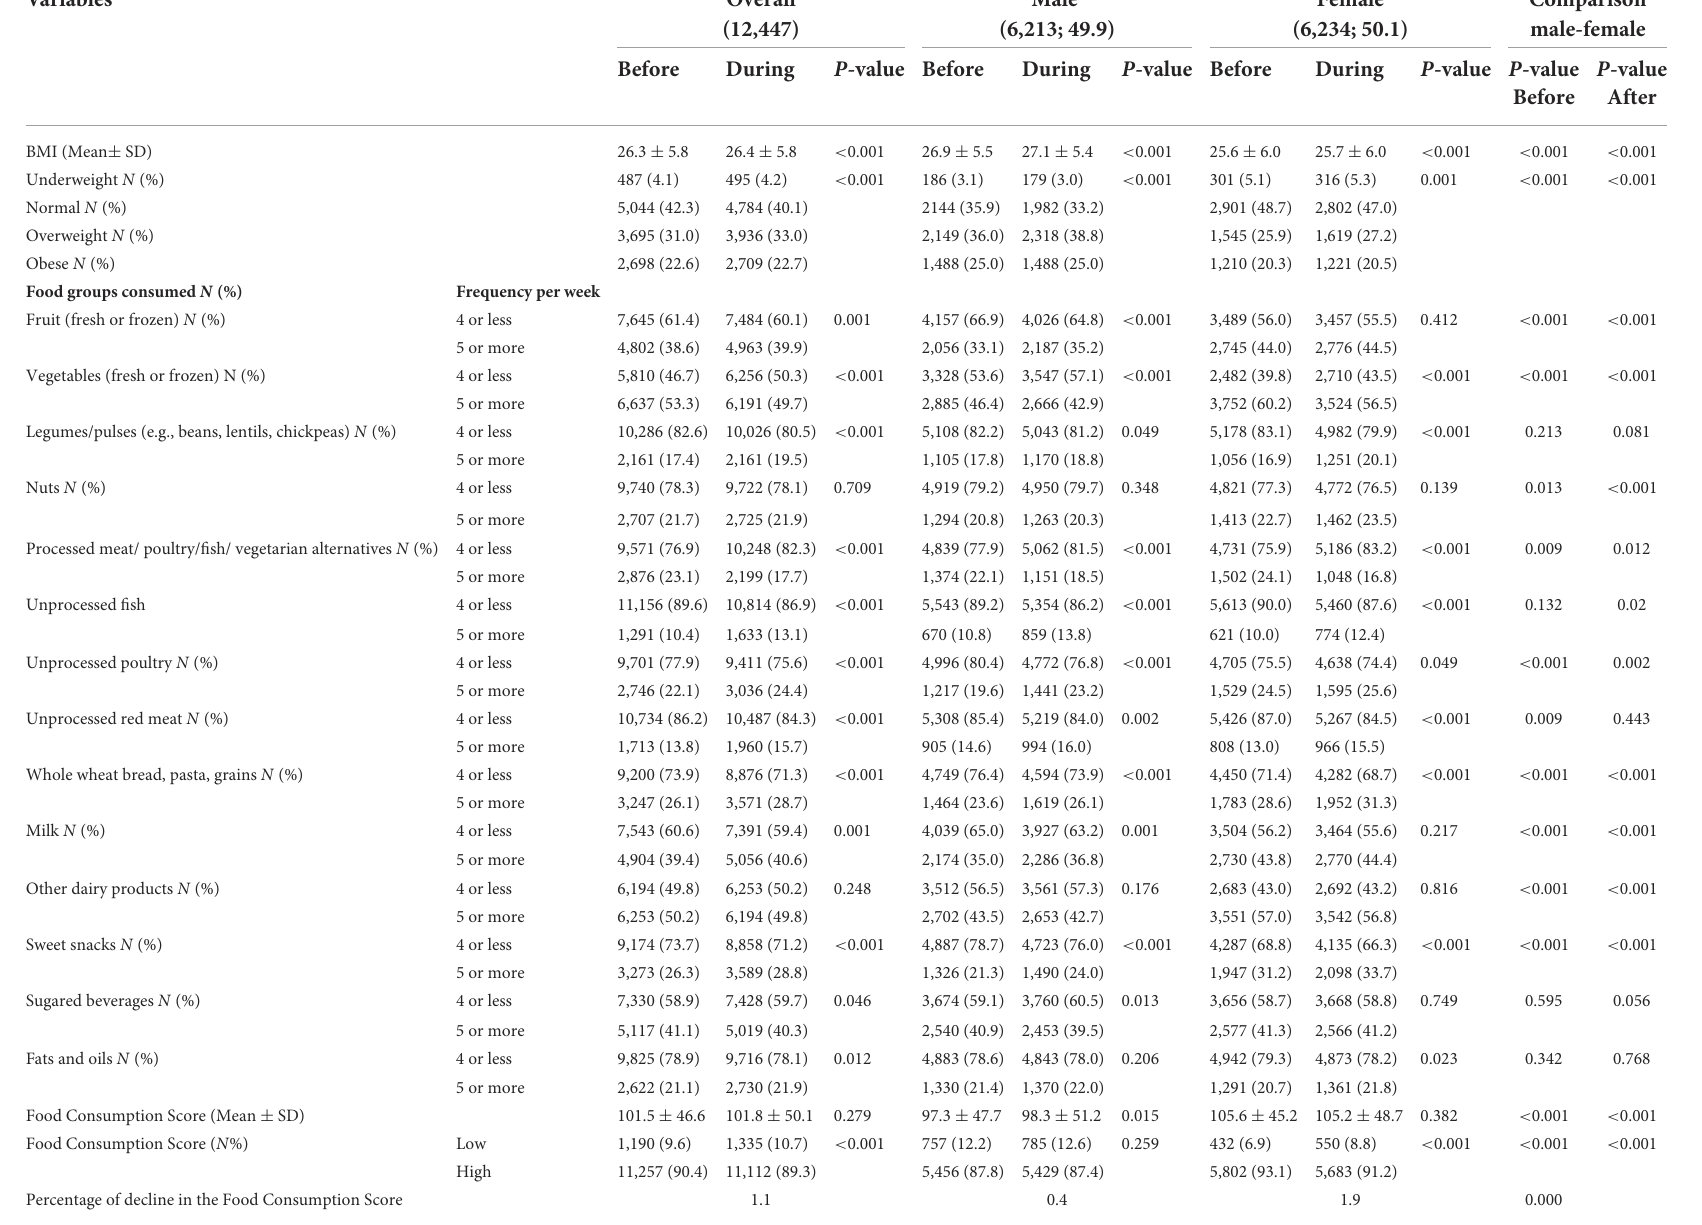
TABLE 2 Food groups consumption among study participants before and during the COVID-19 pandemic based on